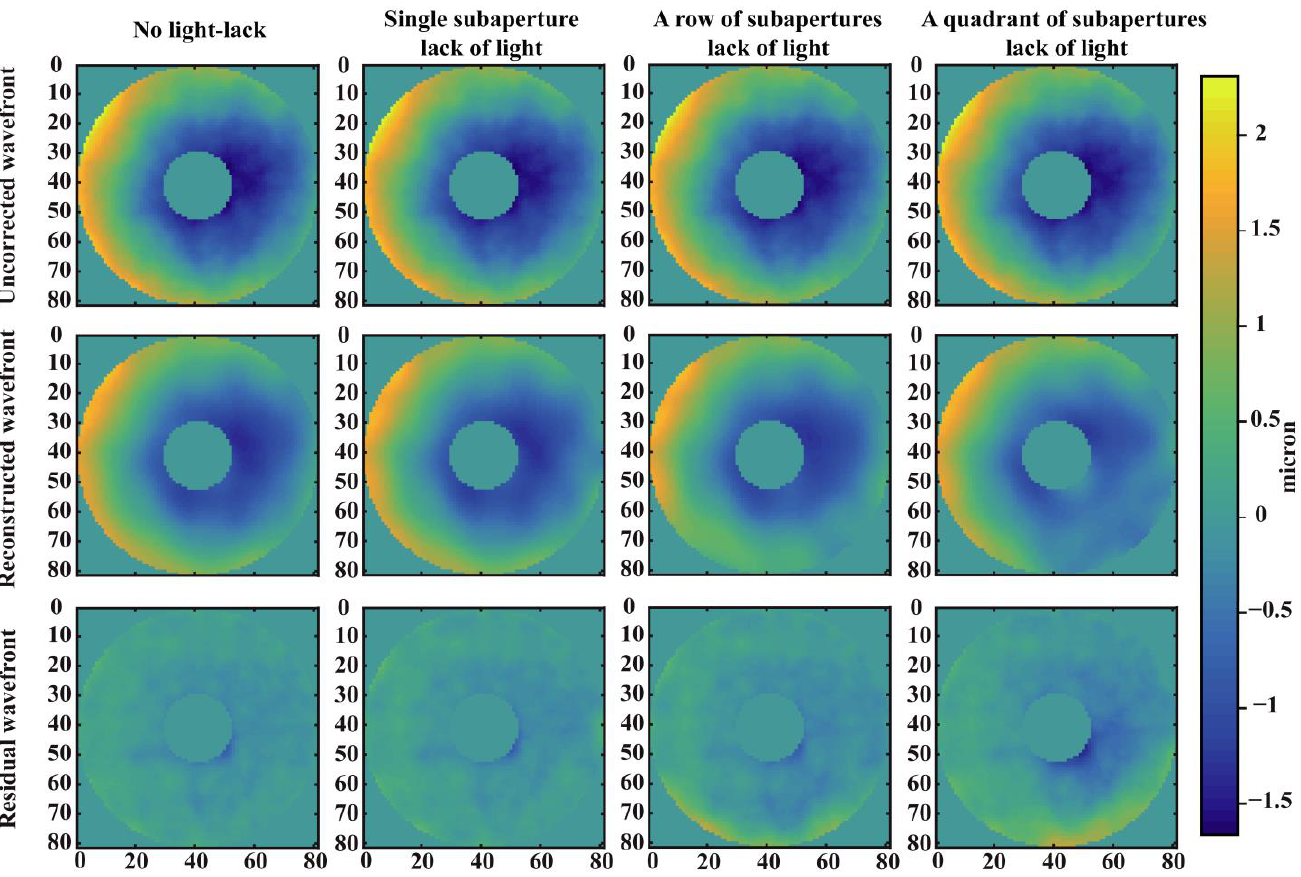
Figure 11. The influence of under-sampling on the mixed aberrations in these three cases. The first row is the initial aberrant wavefront, the second row is the reconstructed wavefront under these three cases and the last row is the residual wavefront after correcting the initially mixed aberrations.